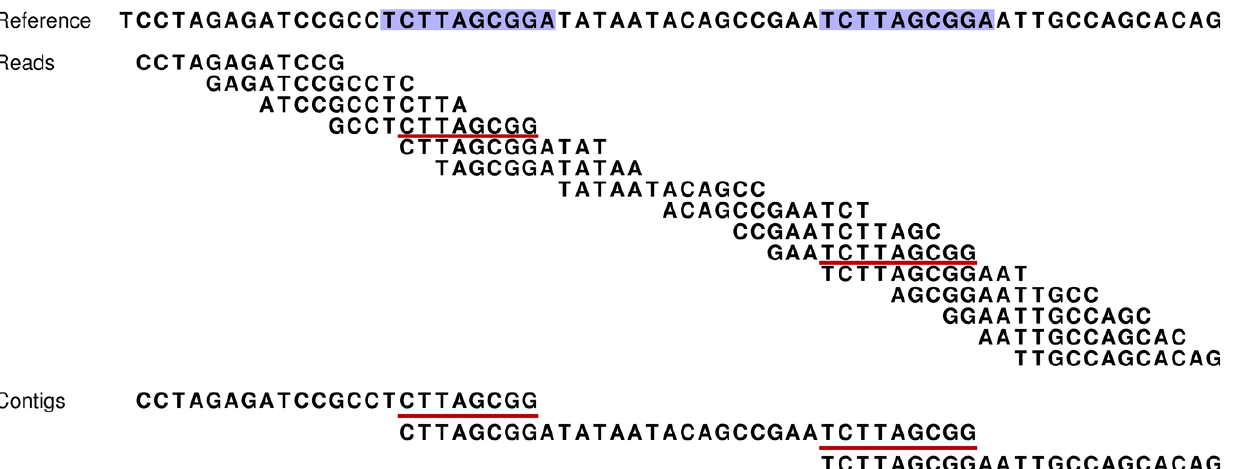
Figure 1. How our assembly simulator works to determine which contigs are theoretically possible (and conversely, which are not). At the top, a short stretch of sequence is presented for a reference genome [3]. This short region includes two direct repeats (blue shading). Fifteen reads (without sequencing errors) are given for this region and are ordered according to their overlapping sequences. However, the occurrence of the two repeats introduces ambiguities that make this ordering ambiguous (e.g., contig one could be directly linked to either contig two or three). Such ambiguities result in contig breakpoints, and thereby, increased numbers of shorter contigs. Our assembly simulator recognizes these breakpoints as those overlaps of successive reads (red underlining), which occur multiple times in the reference